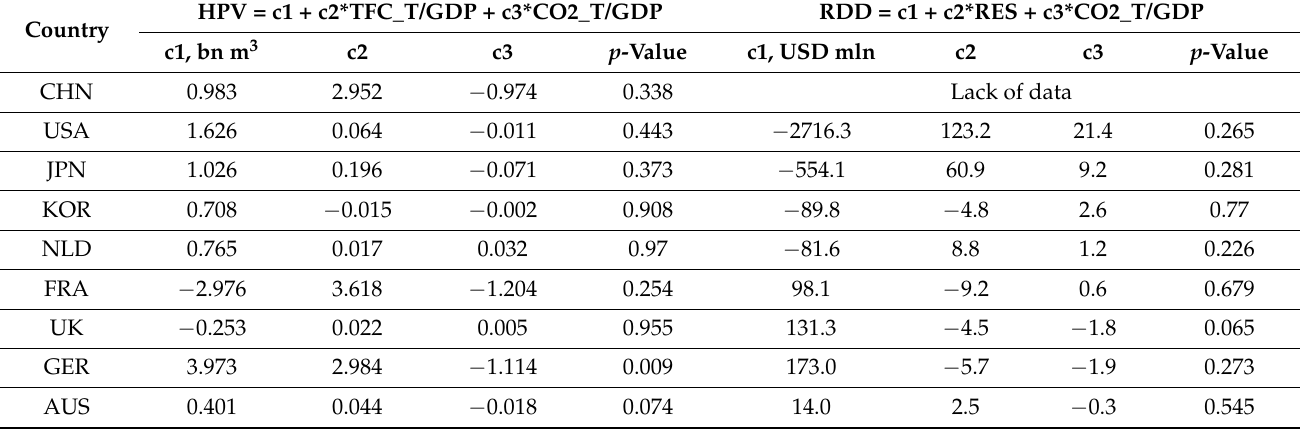
Table 3. The values of the regression coefficients c1, c2, c3 (according to Formula (4)) for pairs x d1 and x d2 were selected based on Tables 1 and